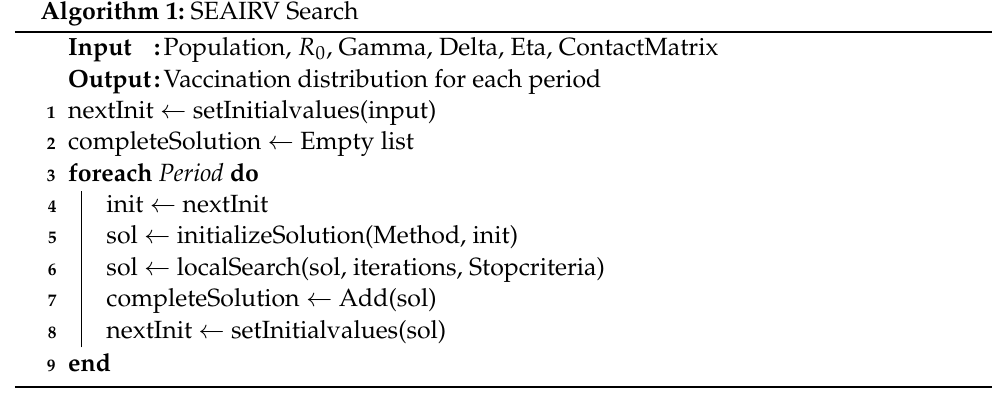
Algorithm 1: SEAIRV